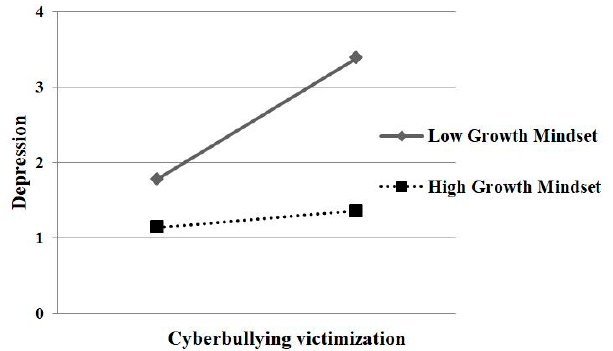
Figure 1. Growth mindset moderated the relationship between cyberbullying victimization and depression.